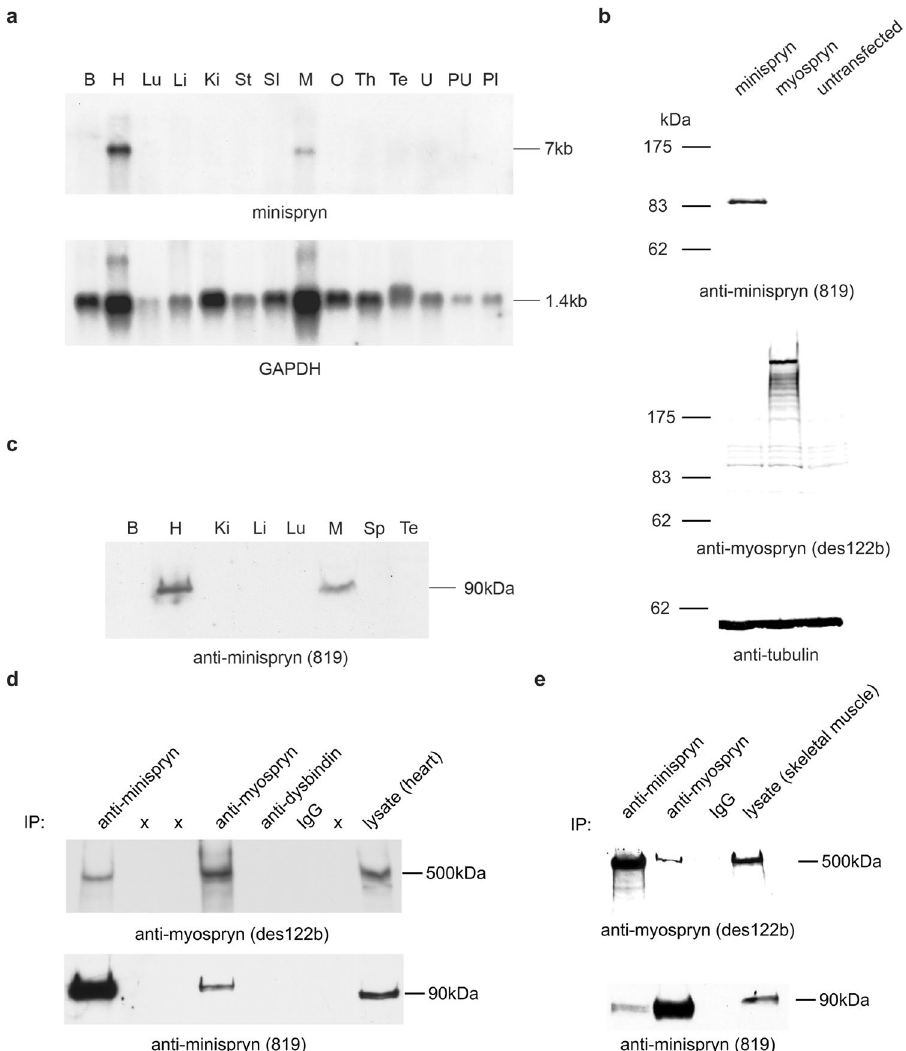
Figure 2. Minispryn transcript and protein. ( a ) Northern blot showing the size and tissue distribution of the murine minispryn transcript. A single band of approximately 7 kb is only detected in heart and skeletal muscle. The blot was stripped and re-hybridized with a GAPDH probe to demonstrate the presence of mRNA in each lane. Key: B, brain; H, heart; Lu, lung; Li, liver; Ki, kidney; St, stomach; SI, small intestine; M, muscle; O, ovary; Th, thymus; Te, testes; U, uterus; PU, pregnant uterus; Pl, placenta; Sp, spleen. ( b ) Western blot of several mouse tissues showing that minispryn is a protein of approximately 90 kDa that is found predominantly in heart and skeletal muscle. ( c ) Antibody specificities were determined in heterologous cells. Lysates prepared from HEK-293T cells expressing full-length myospryn (clone 21B) and minispryn (clone 7E) were processed for immunoblotting with antibodies detecting their cognate antigen. The 819 antibody only detects minispryn in transfected cells whereas des122 only detects myospryn under the same conditions. The lysates were also immunoblotted with anti-tubulin antibodies to demonstrate similar levels of protein in each transfection. Lysates prepared from untransfected HEK-293T cells are also shown. ( d ) In tissue, minispryn and myospryn were immunoprecipitated from RIPA extracts of cardiac muscle using specific antibodies. Minispryn and myospryn are robustly immunoprecipitated with their cognate antisera but also co-IP with the antisera raised against the paralogous protein. Neither myospryn nor minispryn are immunoprecipitated with unrelated IgG. ( e ) Minispryn and myospryn similarly co-immunoprecipitate from RIPA extracts of skeletal muscle. X denotes an empty